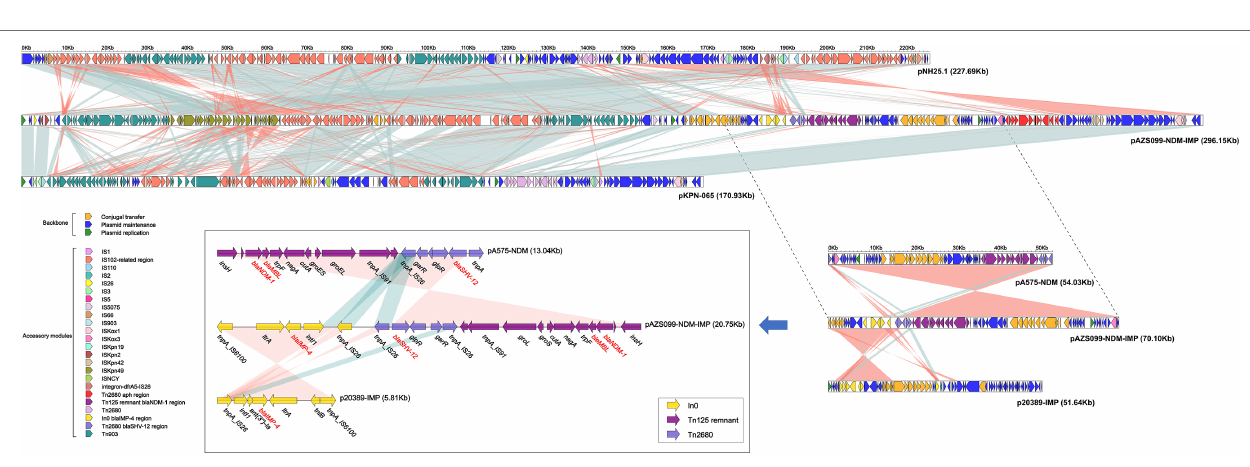
FIGURE 3 | Structure of plasmid pAZS099-NDM-IMP coharboring bla NDM-1 and bla IMP-4 and related transposon and integron. Linear comparison of plasmid pAZS099-NDM-IMP with four most similar plasmids (pNH25.1, pKPN-065, pA575-NDM, and p20389-IMP) and structure comparison of transposon Tn125 remnant containing bla NDM-1 and integron In0 containing bla IMP-4 . Genes are denoted by arrows. Genes, mobile elements, and other features are colored based on functional classification. Shading denotes the regions with high homology (95% nucleotide